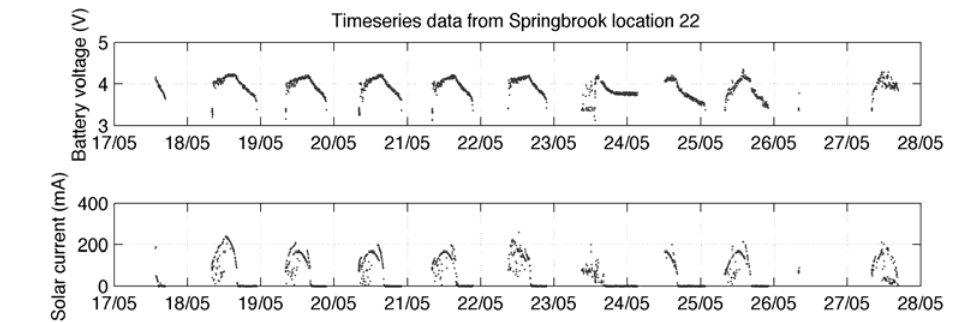
Figure 8. Solar current and battery voltage in full sunlight